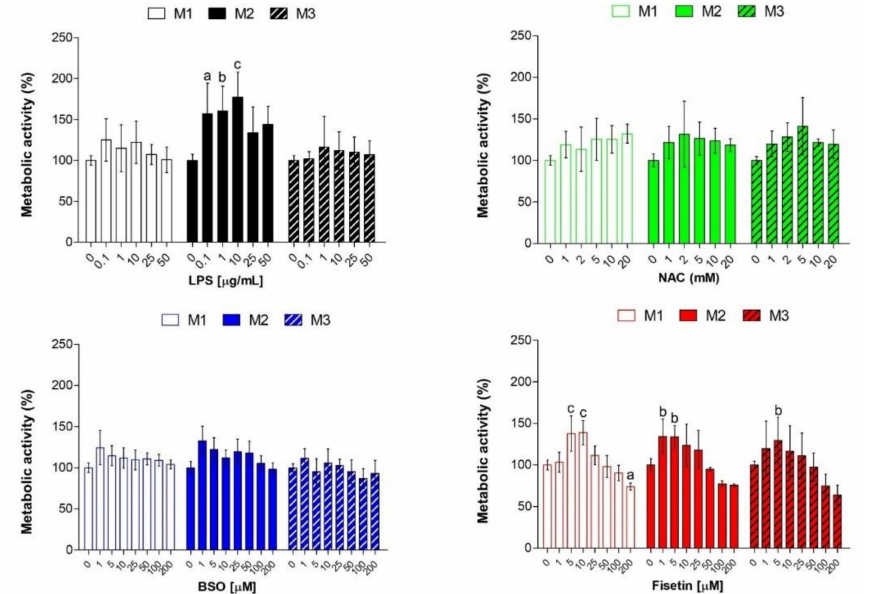
Figure 1. Cell metabolic activity in human pulp cells. Cell cultures were exposed to LPS, NAC, BSO or fisetin for 24 h. Optical density readings in untreated cultures (0 µ M) were set to 100%. Bars show mean values ± standard deviations summarized from individual values in independent experiments (n = 4). M1 = complete growth medium; M2 = complete growth medium with dexamethasone and β -glycerophosphate; M3 = complete growth medium with dexamethasone, β -glycerophosphate and ascorbic acid. Lower case letters indicate significant differences between untreated cell cultures (0 µ M) and treated samples: a ( p < 0.01), b ( p < 0.001) and c ( p <